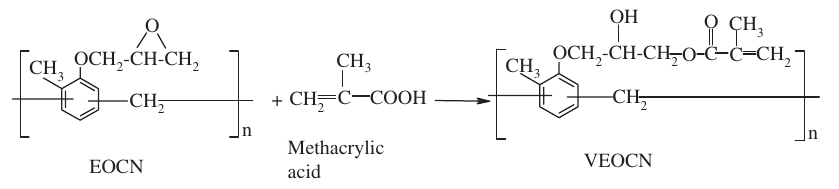
Figure 1: Reaction Scheme for the synthesis of